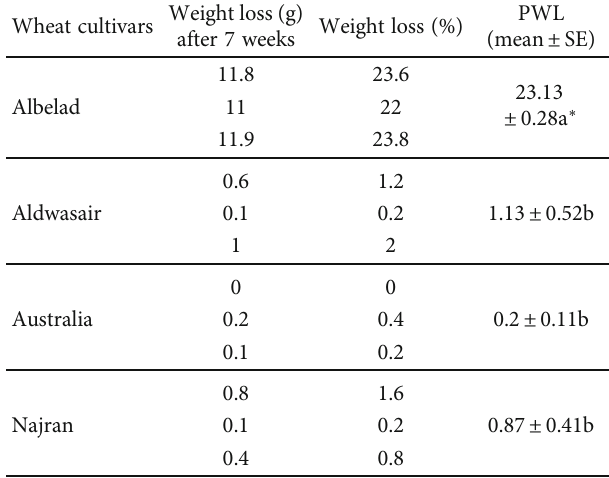
Table 5: Percentage weight loss (PWL) of wheat